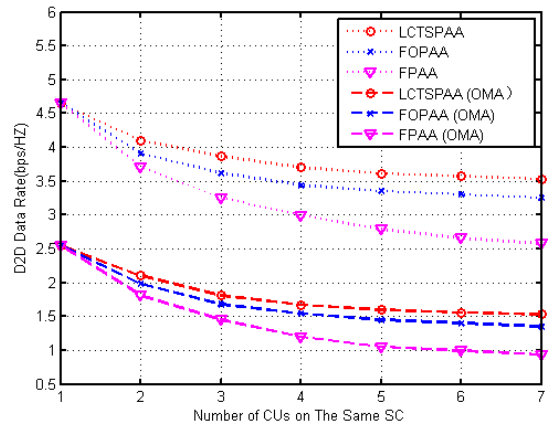
Figure 8. D2D data rate versus number of CUs on the same SC. We study how the number of users influences the data rates on each SC where the number of the users changes from 1 to 7.